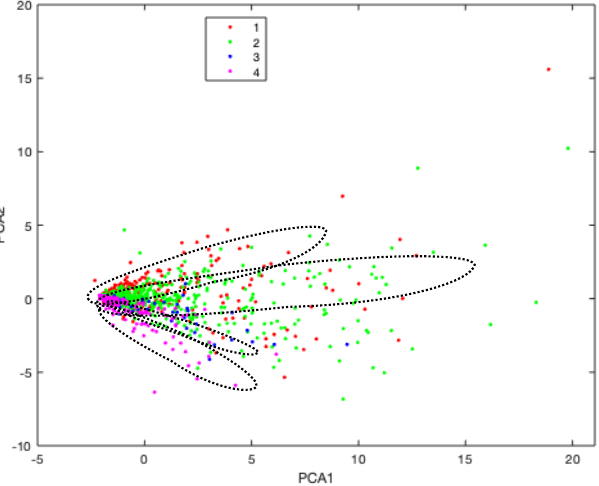
Figure 6. Position of companies in 2-dimensional